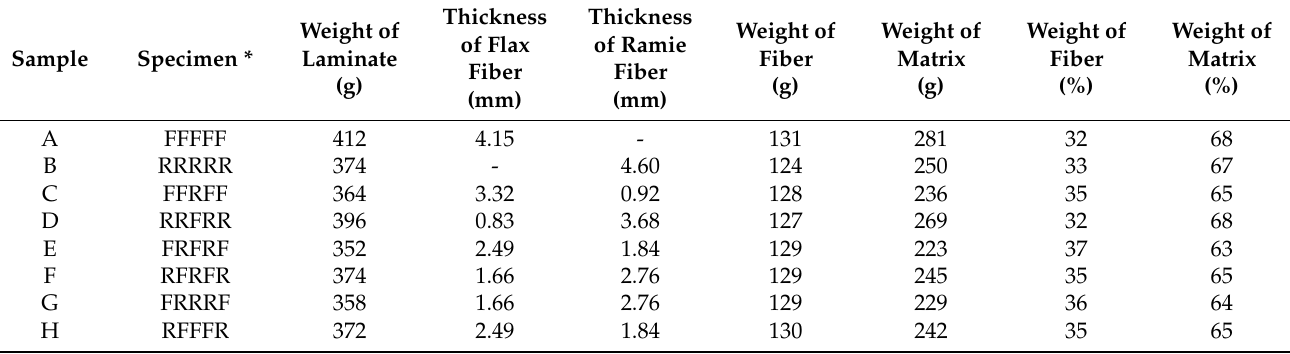
Table 2. Sequence of prepared specimen.